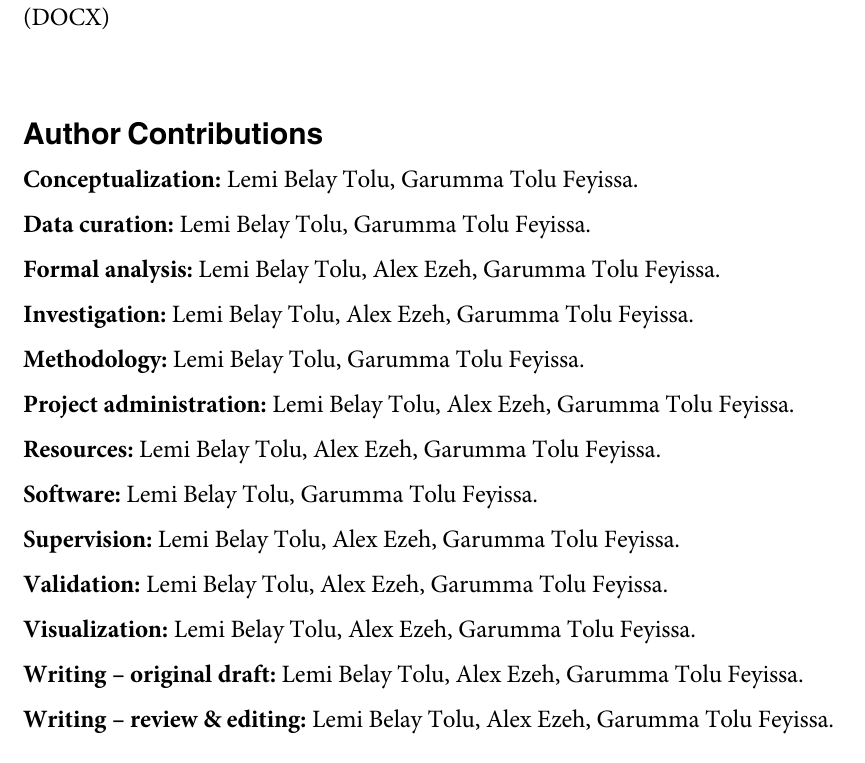
S1 Table. The PRISMA